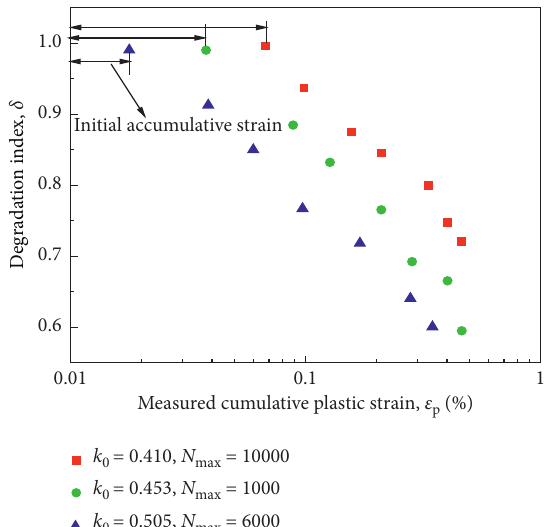
Figure 12: Relationship of K